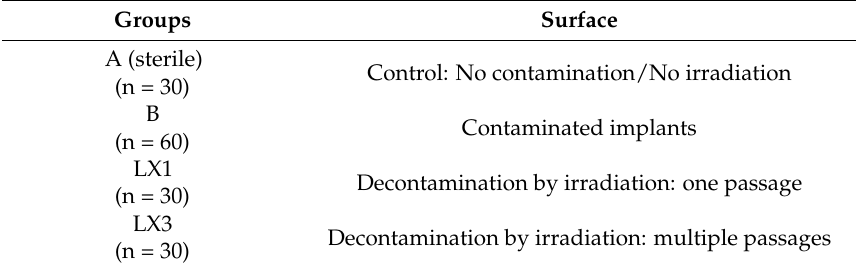
Table 1. Distribution of the experimental and the control